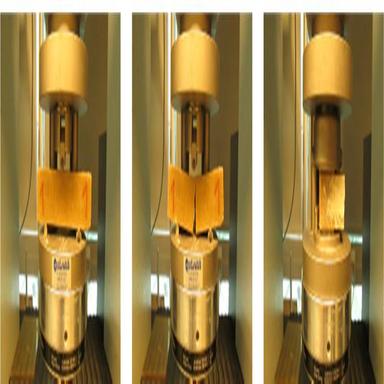
Three-point flexural test (left, middle), compression test on the broken sample (right).